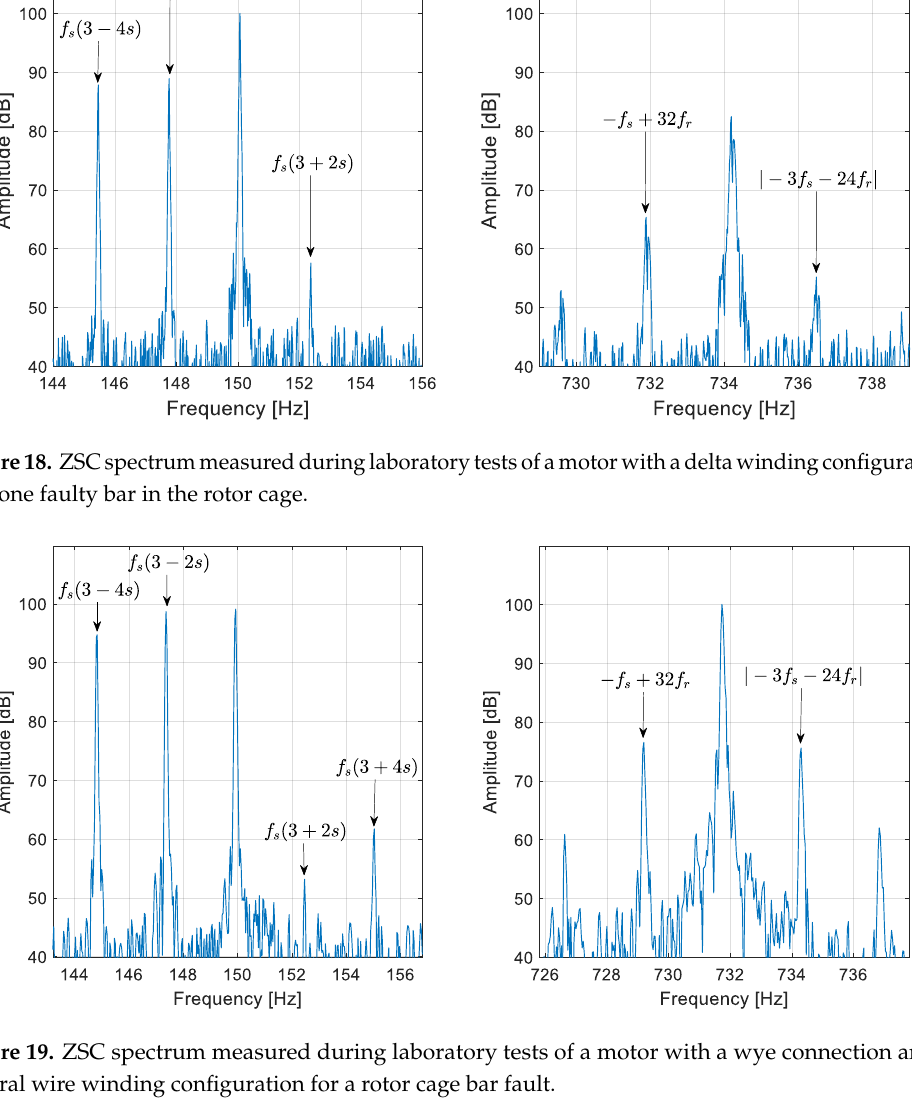
neutral wire winding configuration for a rotor cage bar fault.